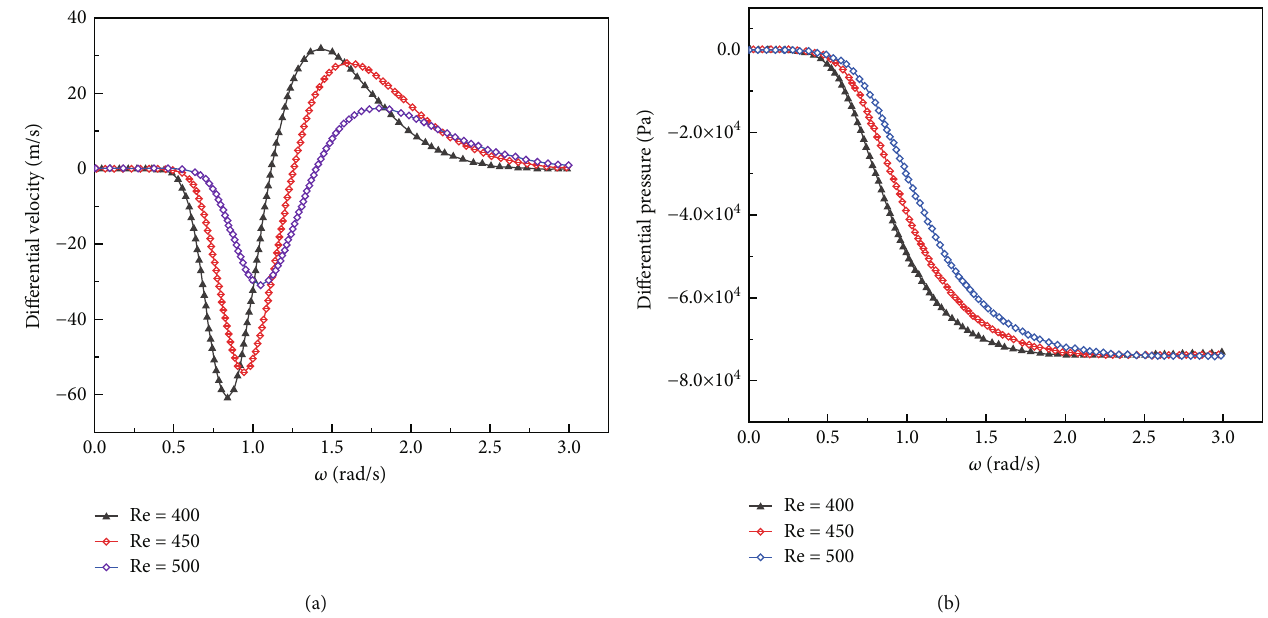
Figure 5: Distribution of the steady fl ow fi eld in an expanding pipe at a given